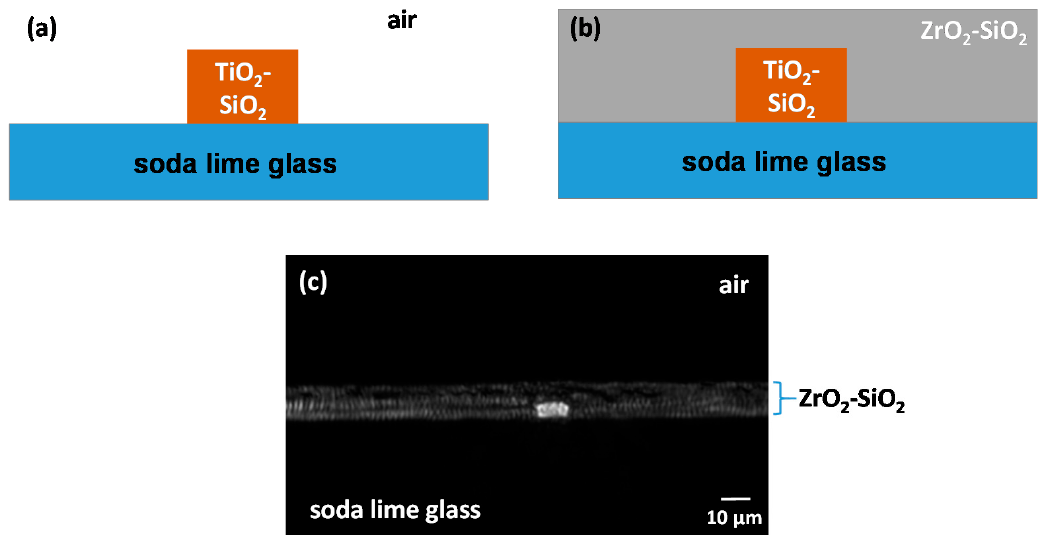
Figure 10. Two configurations of the photonic device deposited on soda-lime glass. ( a ) TiO 2 –SiO 2 core without cladding and surrounded by air. ( b ) TiO 2 –SiO 2 core buried in a ZrO 2 –SiO 2 coating and ( c ) output light of the TiO 2 –SiO 2 core waveguide with ZrO 2 –SiO 2 cladding obtained experi- mentally.